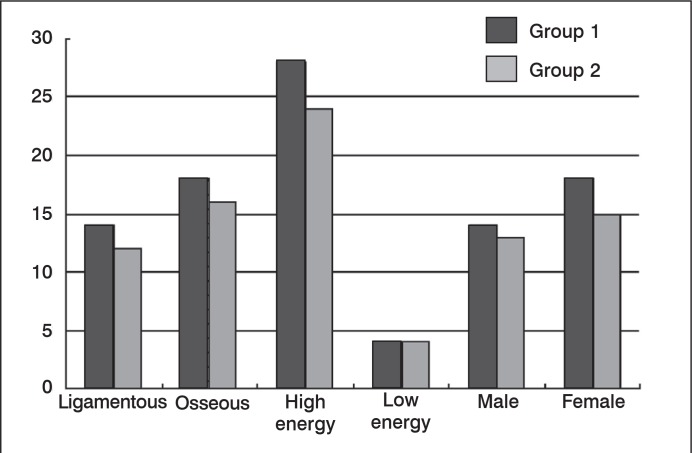
Details about the types of injuries and the causes of injuries.